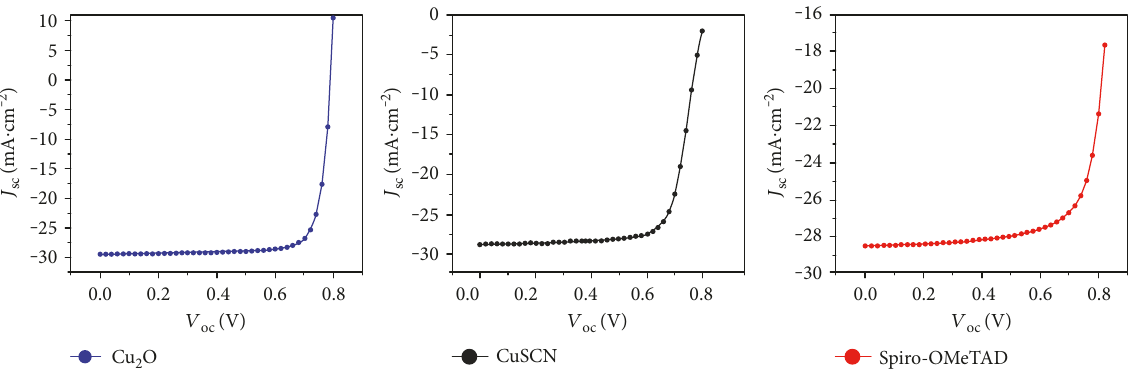
Figure 9: J - V curves for di ff erent HTM-based PSCs. Table 5: Performance of Pb-free ZnO nanorod-based PSCs with di ff erent HTM layers. Perovskite solar